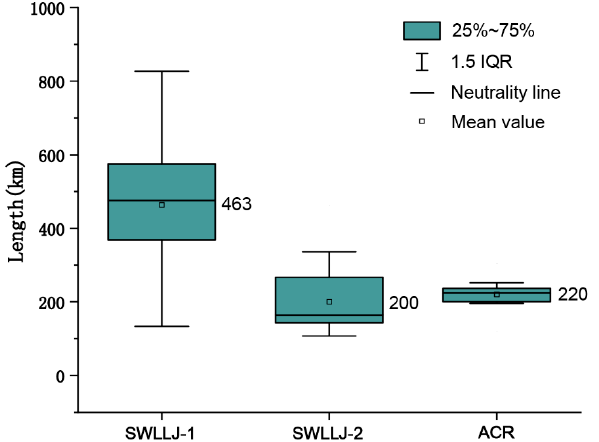
Figure 6. Box charts of along-axis lengths of the OWSRs over South China in the SWLLJ (SWLLJ-1 and SWLLJ-2) and ACR situations. SWLLJ-1 indicates the OWSRs located in the coastal areas of Guangxi Province and Guangdong Province in the SWLLJ situation, and SWLLJ-2 indicates the OWSRs located at west Guangdong Province and east Guangdong Province in the SWLLJ situation. The numbers indicate the mean along-axis lengths (units: km) for the OWSRs of SWLLJ-1, SWLLJ-2, and ACR.